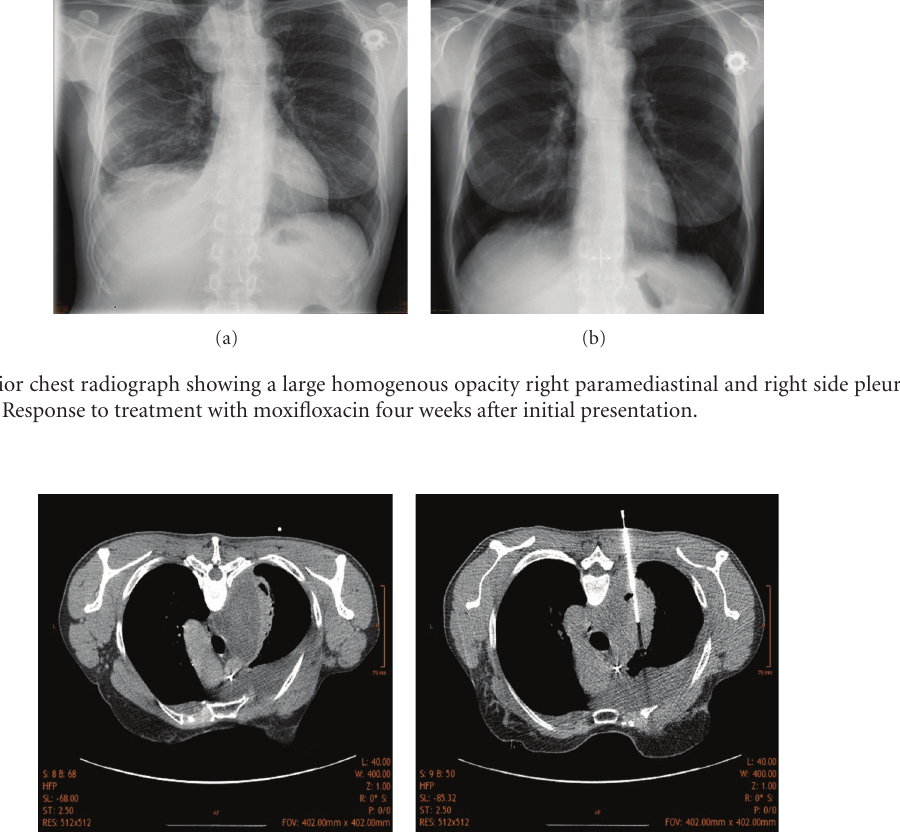
Figure 2: Computed tomography (CT) scan of the chest with CT-guided needle biopsy of a right paramediastinal tumor. In total 10 biopsies were taken from the 8.4 cm large mass.